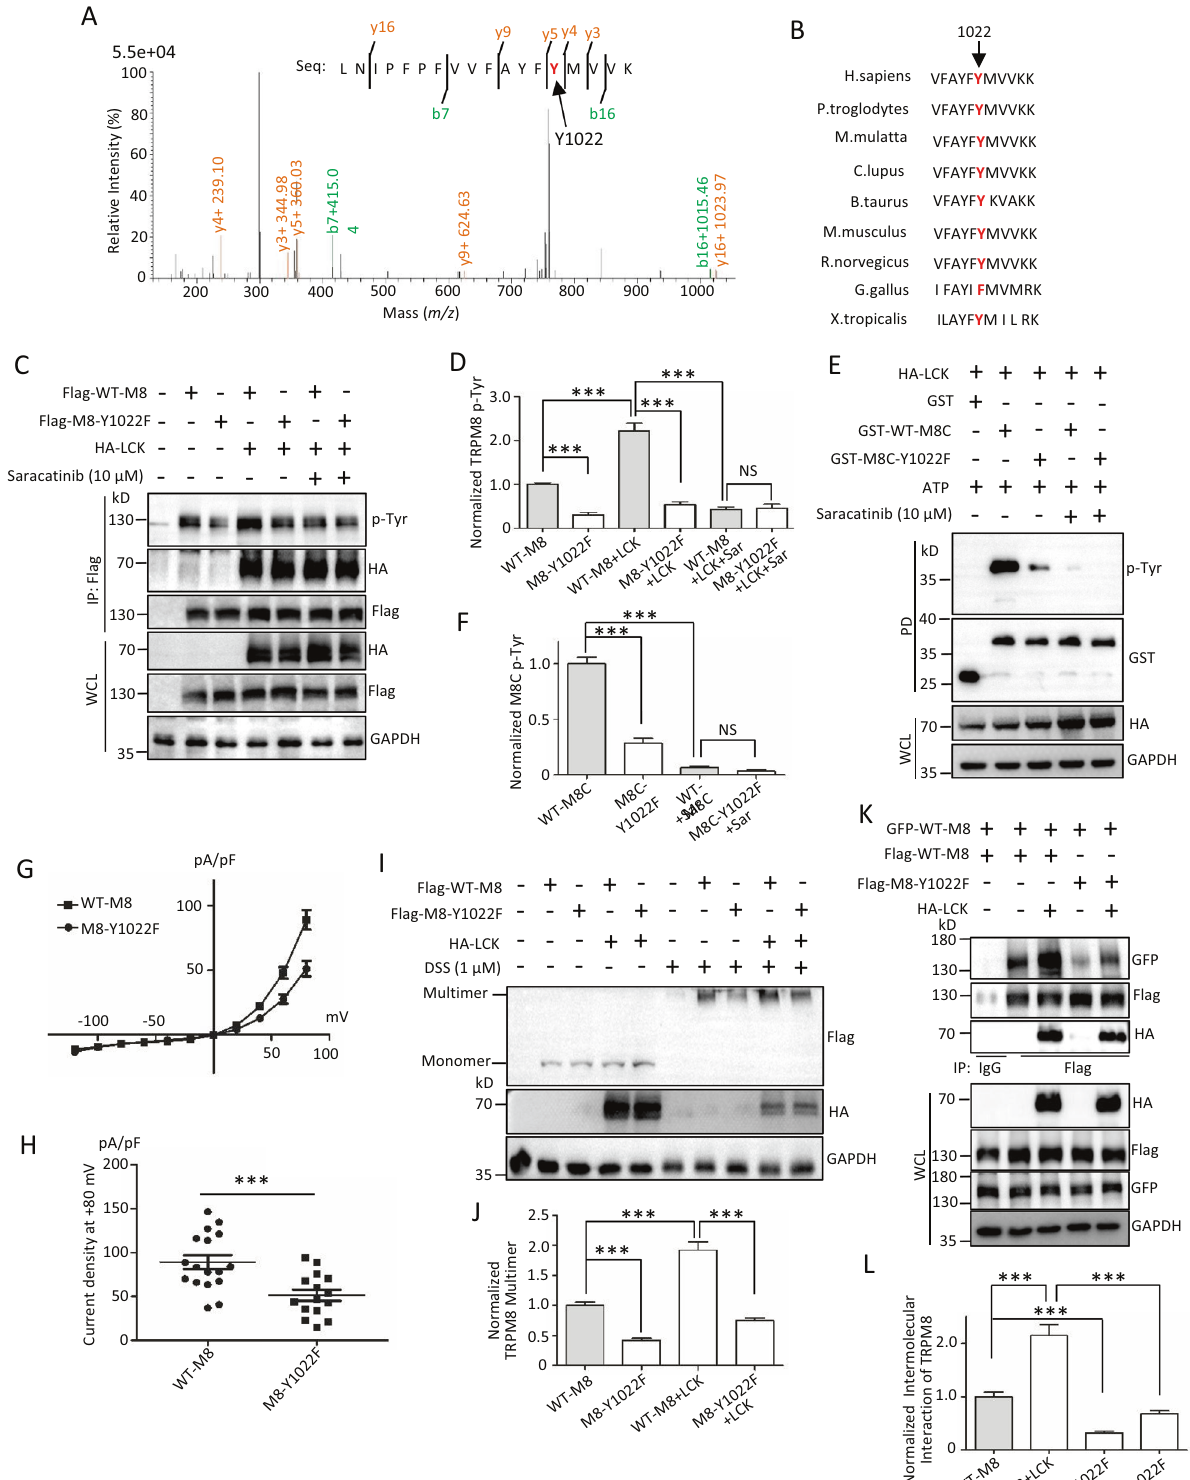
14-3-3 protein family, was identi fi ed in the same screen at ~30 kD bands as in our previous studies in Fig. 1a [10] (Fig. S1E, F). We fi rst demonstrated the interaction of 14-3-3 ζ and the C-terminus of TRPM8 by an in vitro GST pull ‐ down assay (Fig. 5A) and 14 – 3 – 3 ζ and TRPM8 in native PANC-1 cells by Co-IP assay (Fig. 5B),